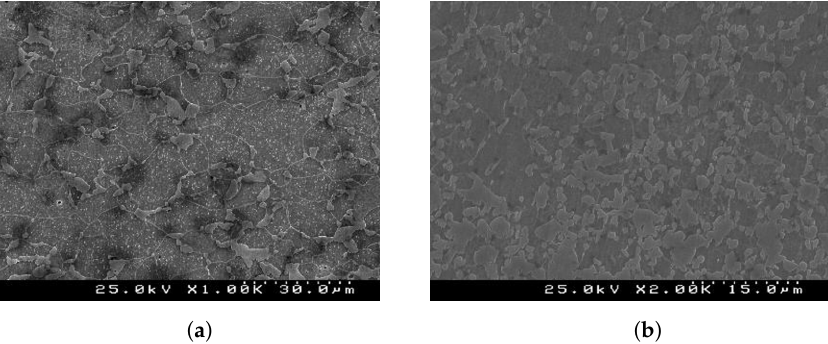
Figure 1. Initial microstructure obtained from SEM of ( a ) DP500 and ( b ) DP780 dual-phase steel. Table 1. Chemical composition of the DP500 and DP780 dual-phase